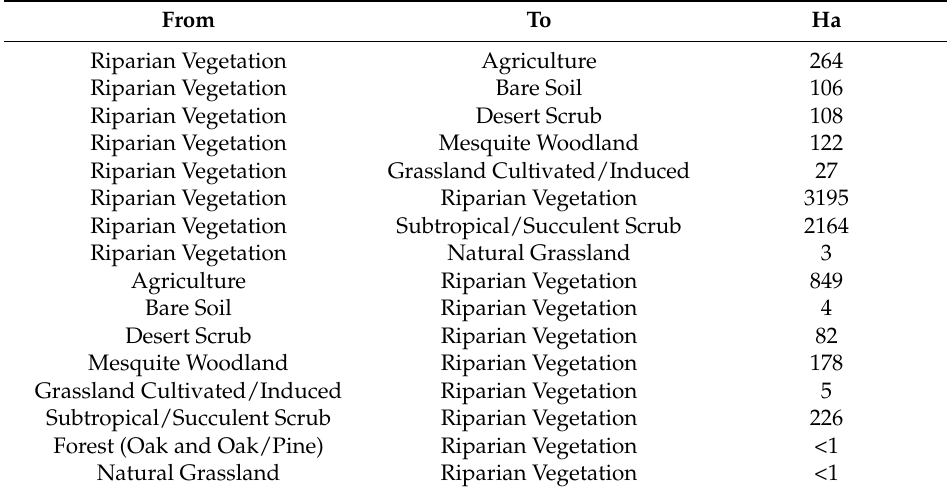
Table 9. Changes in riparian vegetation related to Water depth less than seven meters (changes from 2002 to 2011). From